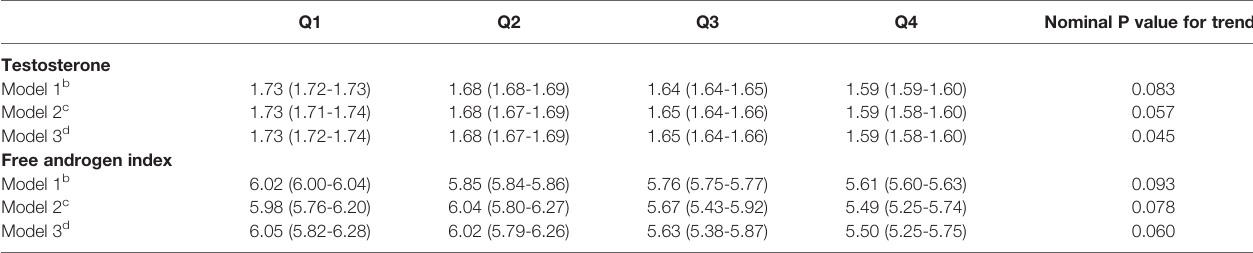
TABLE 3 | Calculated means (95% con fi dence interval) of testosterone and free androgen index across quartiles of serum magnesium after adjusting covariates. Q1 Q2 Q3 Q4